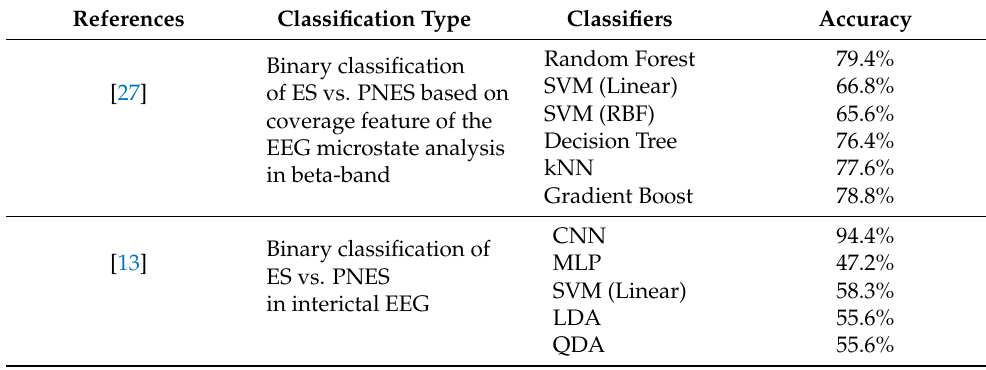
Table 3. Comparison of accuracy results with ES vs. PNES classifications proposed in the